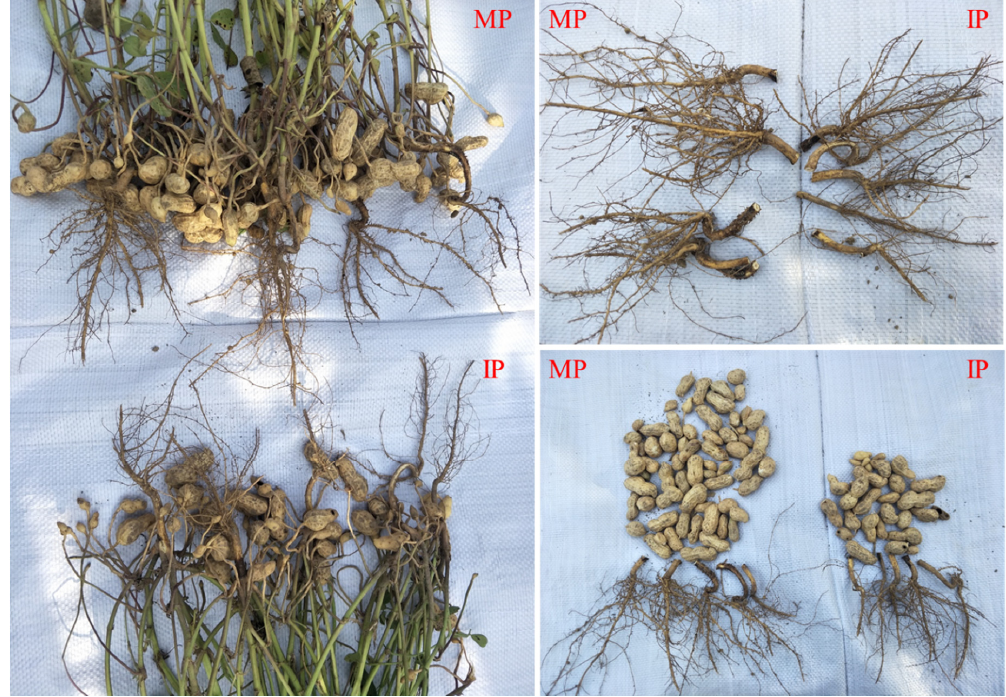
Figure 3. Peanut (five plants) in intercropping (at the maize inter-plant distance of 10 cm, IP) and in monoculture (MP) in Dongying.